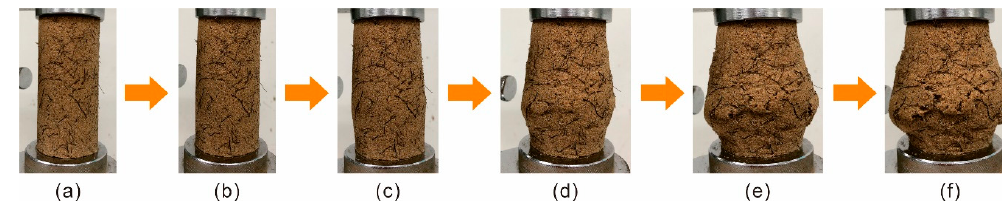
Figure 12. The photographs of treated sand during the UCS test process in ( a ) ε = 0%, ( b ) ε = 5%, ( c ) ε = 10%, ( d ) ε = 17%, ( e ) ε = 23%, and ( f ) ultimate.